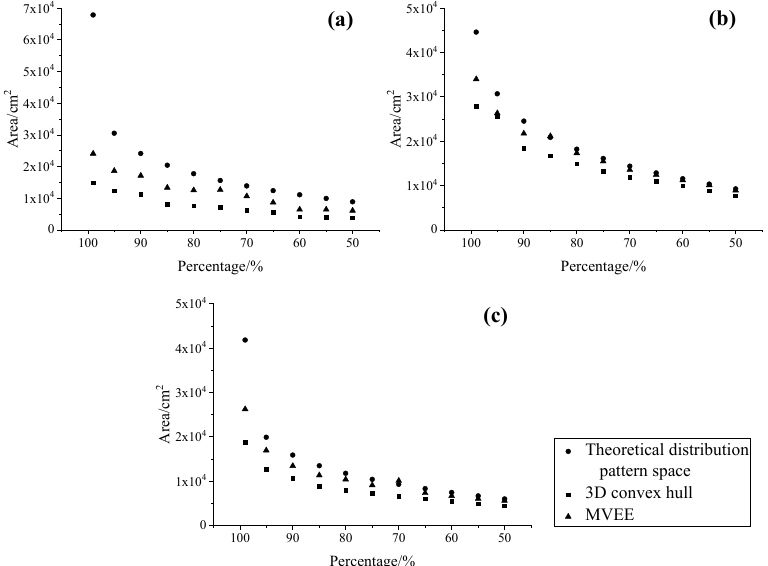
Figure 6. Area evaluation of three methods. ( a ) Area evaluation of Specimen S2. ( b ) Area evaluation of Specimen S3. ( c ) Area evaluation of Specimen S5.